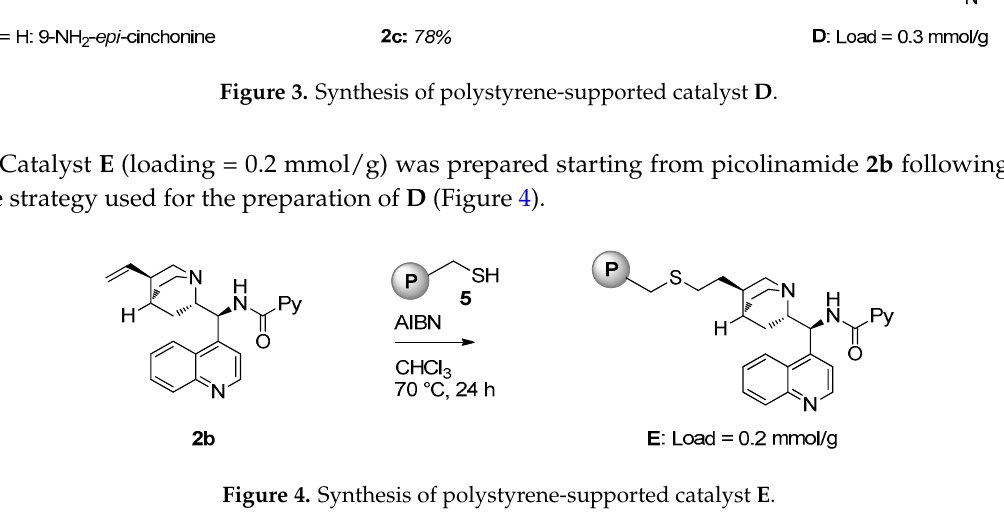
Table 1. Screening of supported catalysts in the reduction of imine 6a with HSiCl 3 .